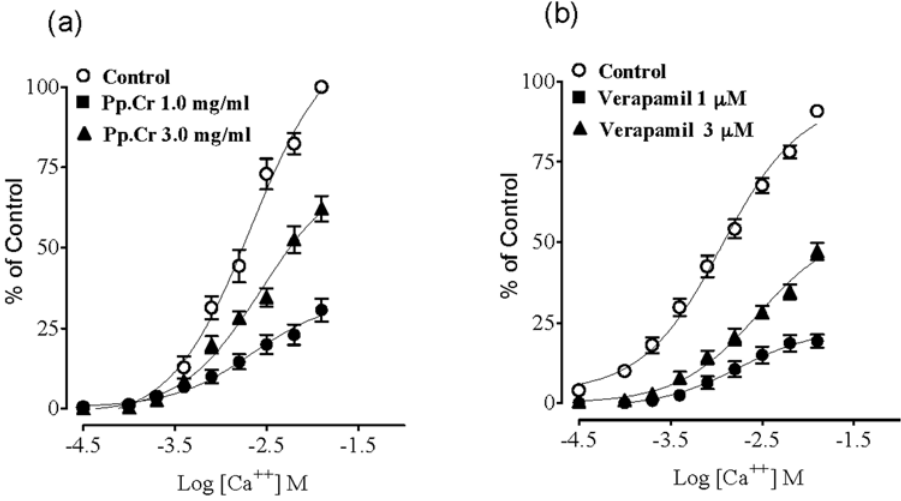
Fig 3. Calcium antagonizing effect of (a) ethanolic extract of Pyrus pashia (Pp.Cr) and (b) verapamil on concentration response curves of Ca 2+ in isolated rabbit jejunum preparations. Values are the mean ± SEM, n = 5. Control CaCl 2 .